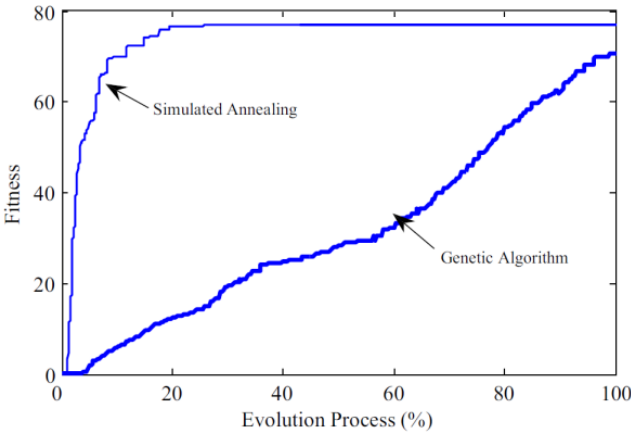
Figure 18. Multi-objective optimization evolutionary process of GA and SA [70].